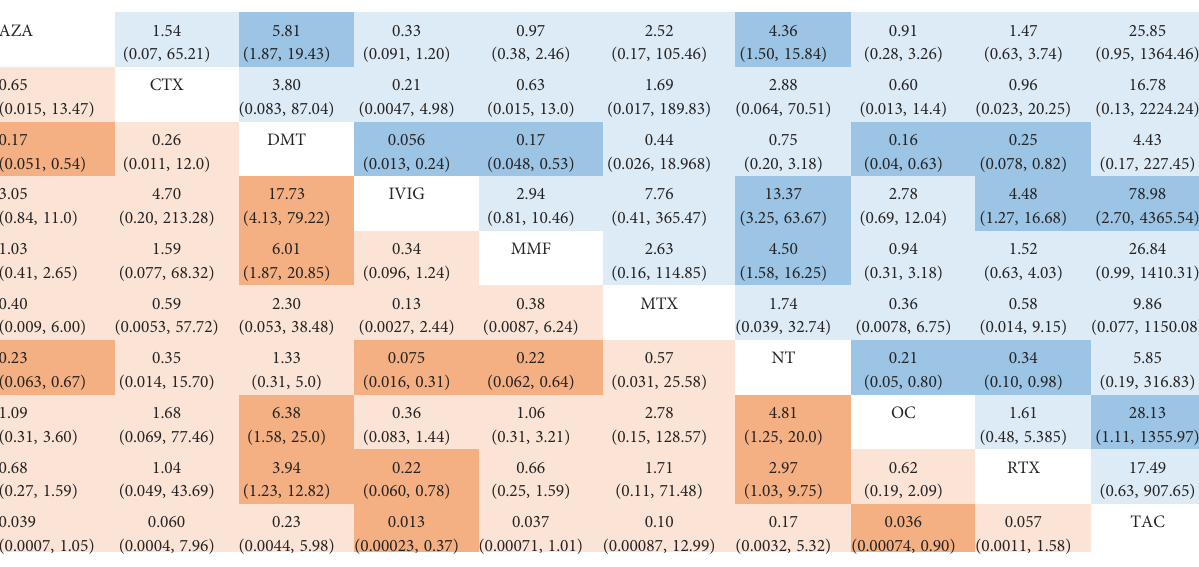
TABLE 2 Estimated odds ratio with 95% credible intervals of different treatments in reducing incidence of relapse in MOG-AD.